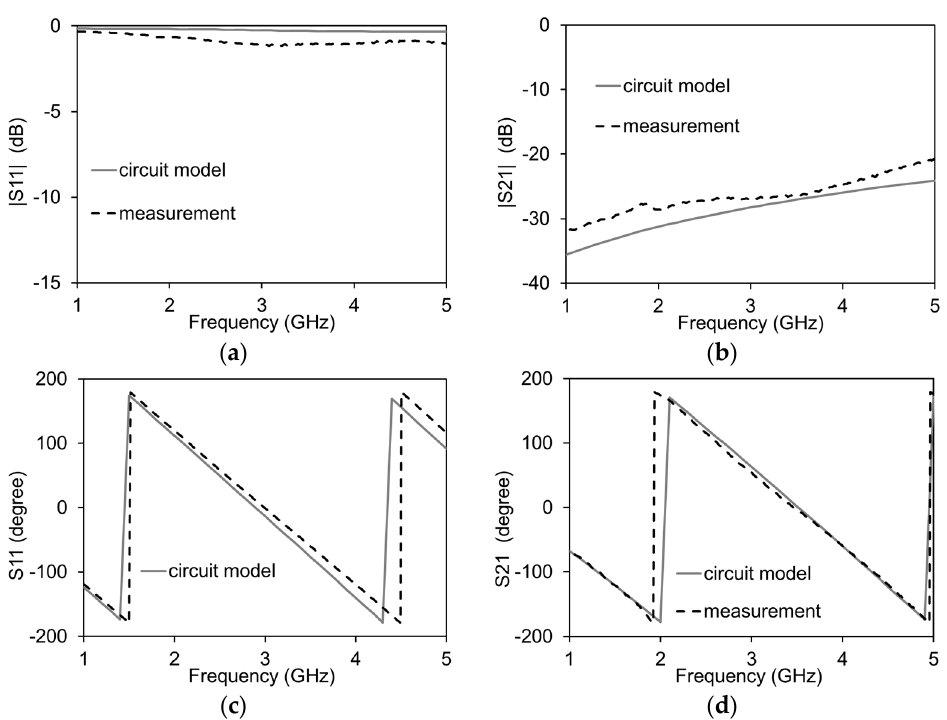
Figure 13. Simulated (solid lines) and measured (dashed lines) scattering parameters of biochar film: ( a ) amplitude of reflection coefficient (dB); ( b ) amplitude of transmission coefficient (dB); ( c ) phase of the reflection coefficient (deg); ( d ) phase of the transmission coefficient (deg).